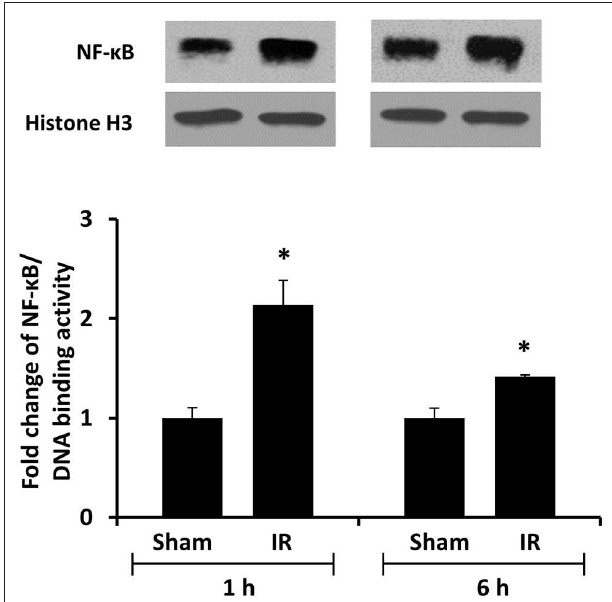
FIGURE 7 | The DNA binding activity of NF- κ B in the liver. The left kidney of rats was subjected to 45min ischemia followed by 1 hour (1h) or 6 hours (6h) of reperfusion (IR). As a control, rats were subjected to a sham-operation without inducing ischemia (Sham). Liver nuclear proteins were prepared. The DNA binding activity of NF- κ B in the liver was determined by EMSA. Histone H3 was determined by Western immunoblotting analysis and used as an internal control. Results are expressed as fold change to the Sham ( n = 5 for each group). * p < 0.05 when compared with the value obtained from the sham-operated